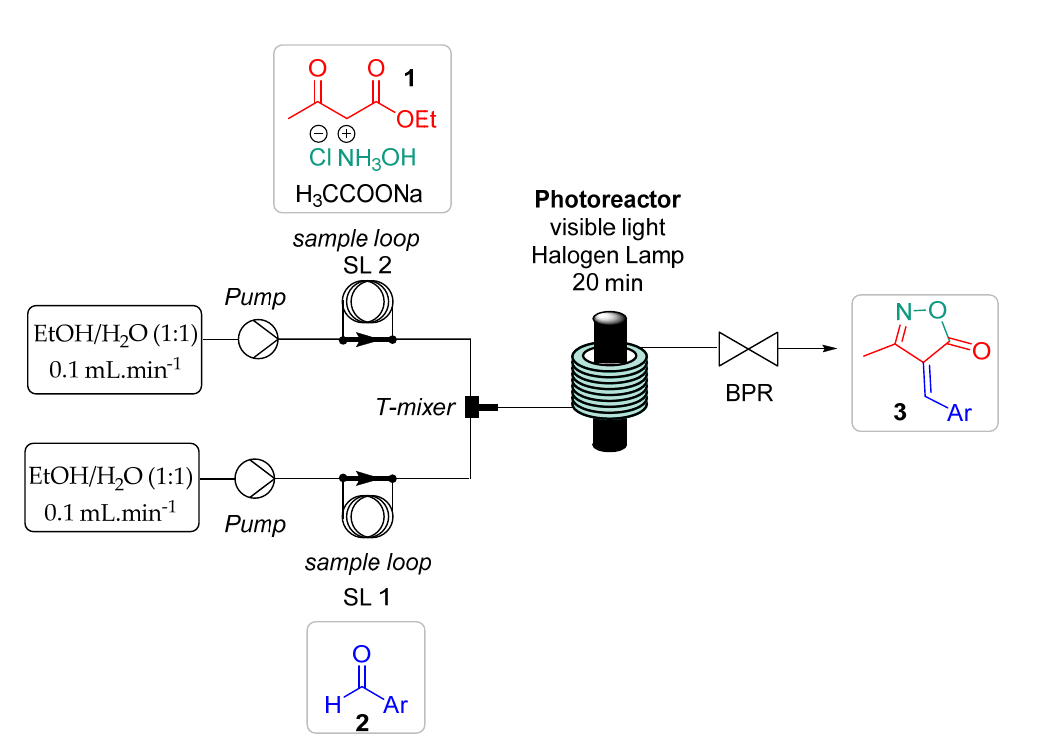
Table 3. Scope for the MCR flow photochemistry synthesis. Entry Isoxazol ‐ 5(4H) ‐ ones Yield (%)